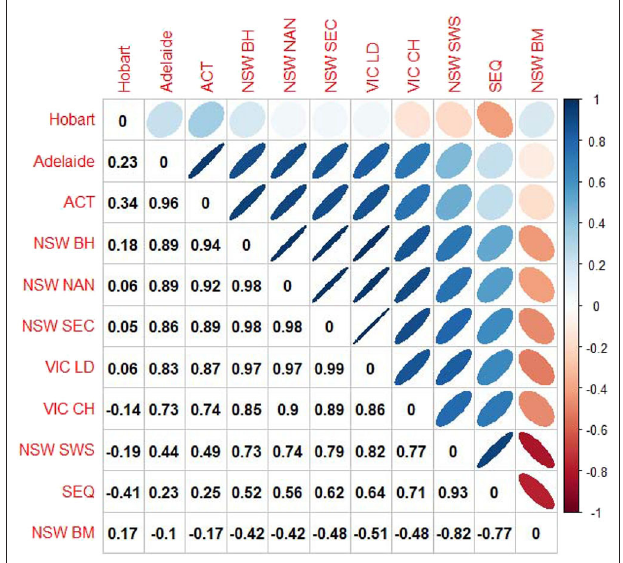
FIGURE 7 | Rank correlations of total cost across the 49 tested prescribed burning scenarios. Color of the ellipses depict the nature of the data, with blue representing positive relationships and red negative. Shape of the ellipses represent the nature of the fit, with thin ellipses representing a strong relationship whereas broad ellipses indicate greater uncertainty in the correlation. Upper right triangle represents the correlation coefficients. Case study codes appear in Table 1 .